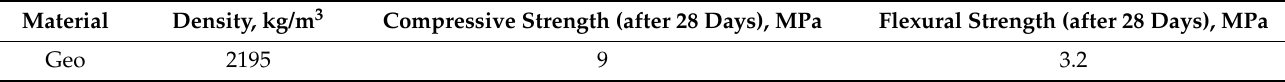
Table 3. Evaluation of optimum produced geopolymer material with S/L ratio (3.5 g/mL) and [KOH]: 8 M. Material Density, kg/m 3 Compressive Strength (after 28 Days), MPa Geo